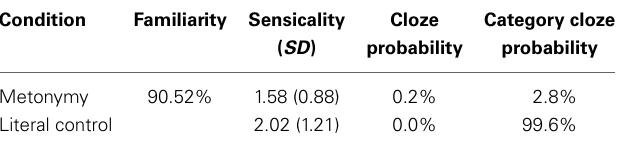
Table 4 | Summary of mean values from pre-tests for selected metonymy and corresponding literal